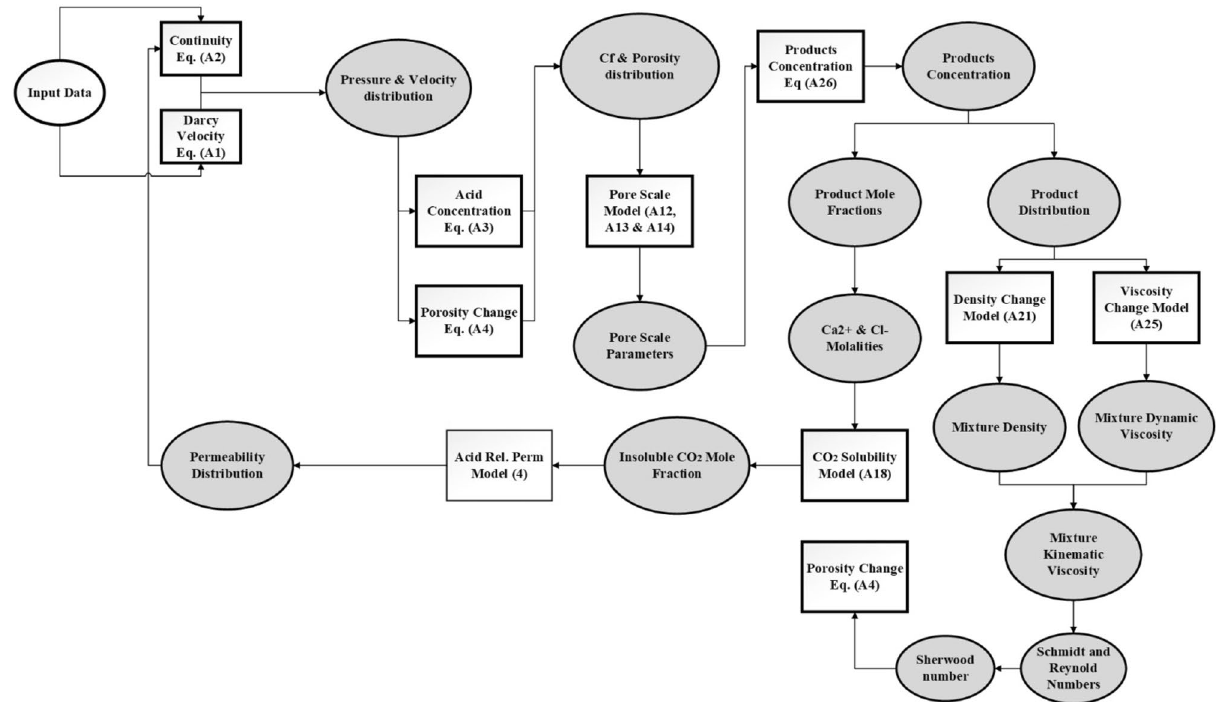
Fig. 2 Flowchart of solving the development continuum model